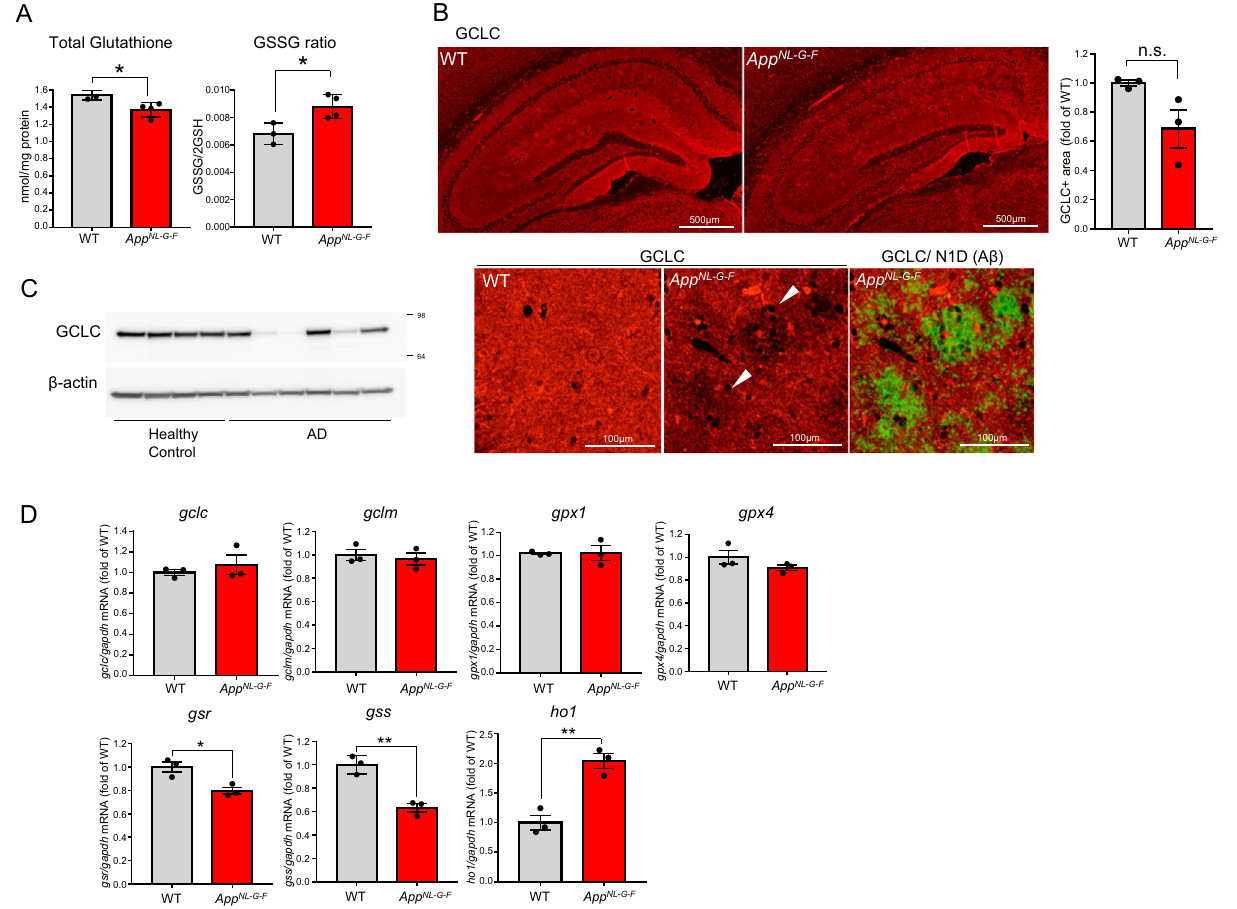
Figure 7. Glutathione homeostasis is disrupted in the presence of amyloid pathology. ( A ) Total glutathione levels (left) and GSSG (oxidized form) to GSH ratio (right) in the cortices of 18-month-old WT and App NL-G-F were determined. Values shown in the graph represent nmol/mg protein (total levels) or ratio of GSSG/2GSH (GSSG ratio) expressed as the mean level ± SEM (n = 3; * p < 0.05). ( B ) Brain sections of 24-month-old wild type (WT) and App NL-G-F were immunostained with GCLC antibody (upper panels). Fluorescence intensity in the hippocampus is quantitatively represented as the mean intensity level ± SEM (n = 3). A magnified image of App NL-G-F showing double-staining for GCLC antibody and Aβ antibody (N1D) (lower panels). ( C ) GCLC protein levels were detected in cortical samples from AD patients and healthy controls. Details of the human samples are provided in Watamura et al. 66 ( D ) mRNA levels of glutathione-related genes in 12-month-old WT and App NL-G-F were determined. Values shown in the graphs represent the mean relative expression level ± SEM (n = 3; * p < 0.05, ** p <